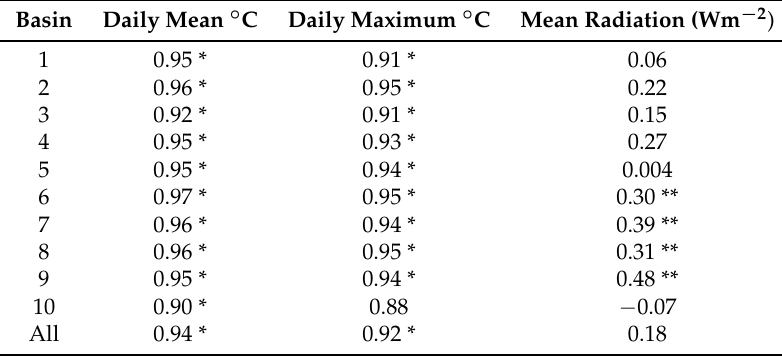
Table 3. Pearson’s correlation coefficients ( ρ ) for relationships of daily mean stream temperature and daily mean air temperature, daily maximum stream temperature and daily maximum air temperature, and daily mean stream temperature and daily mean solar radiation. Daily Mean ◦ C